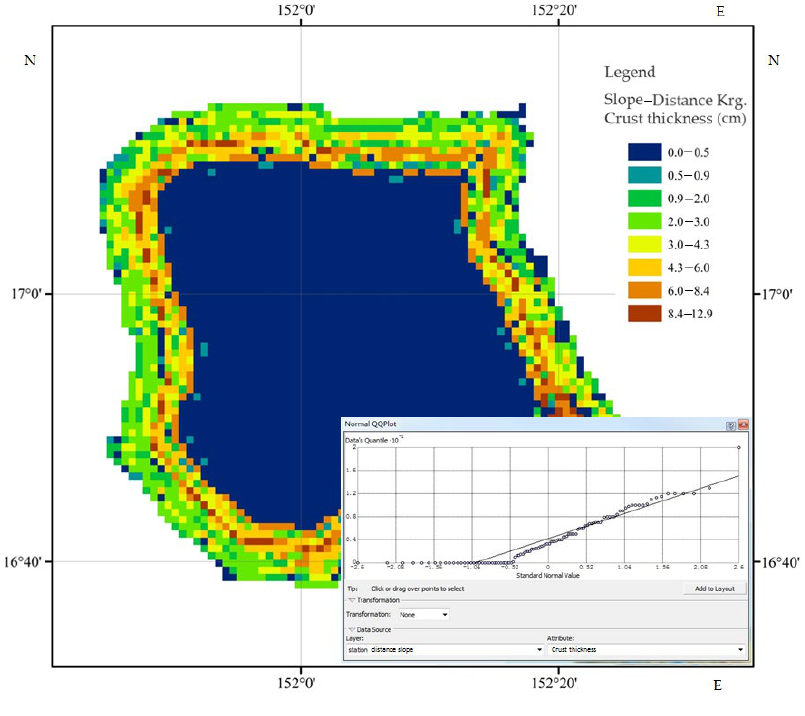
Figure 10. Crust thickness estimation using the “slope–distance” Kriging method.